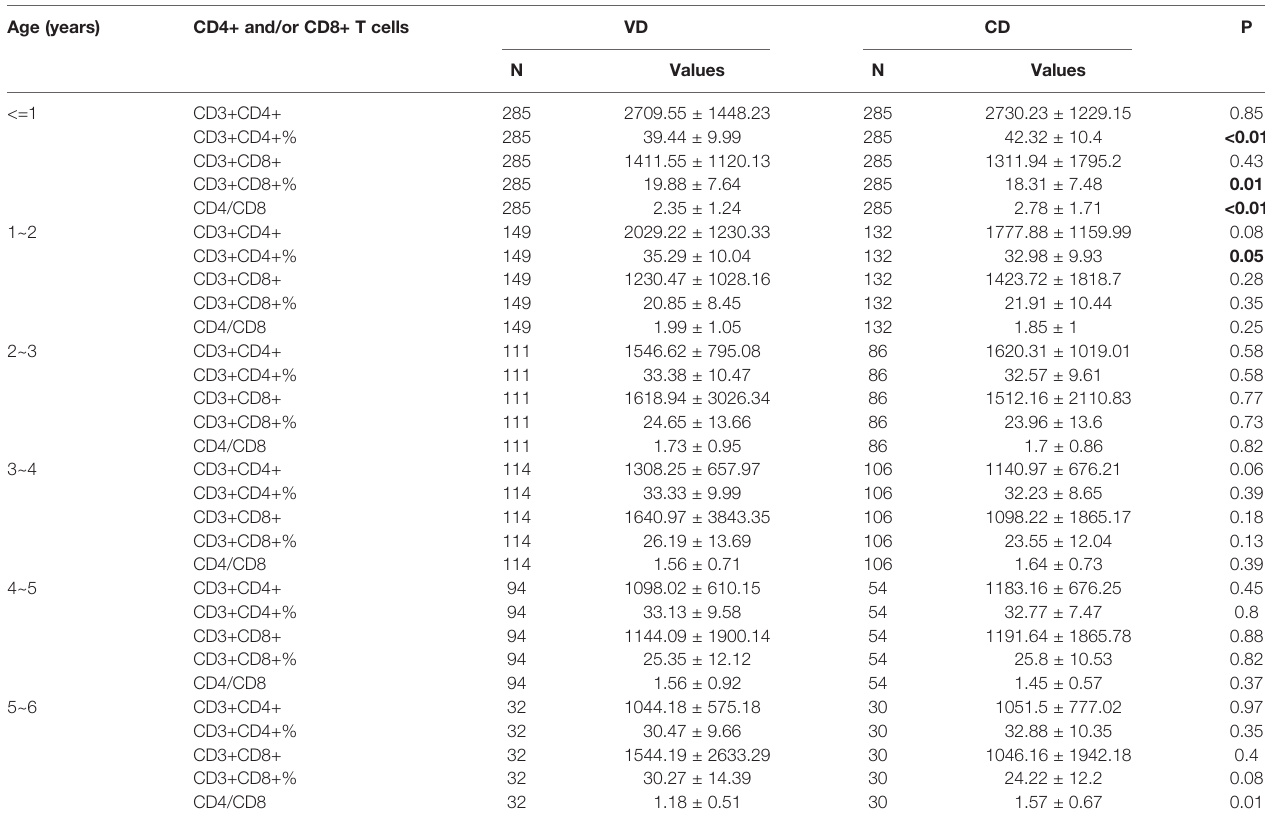
TABLE 3 | The changes of CD4+ or CD8+ T cells between VD and CD group in different age. Age (years) CD4+ and/or CD8+ T